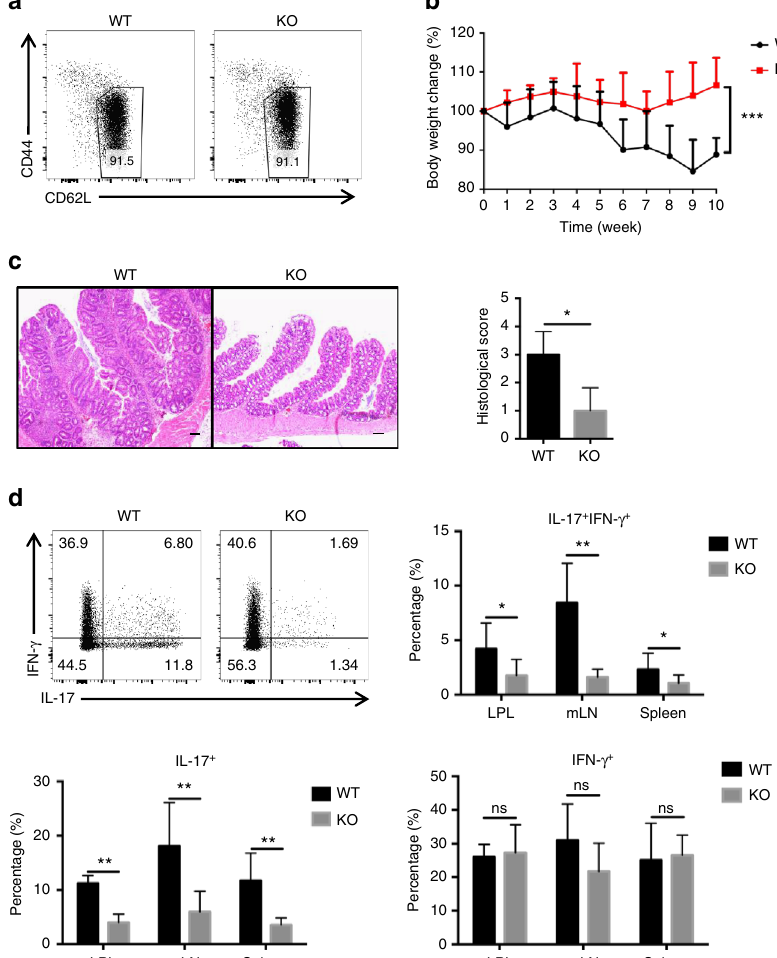
Fig. 1 TRIM28 regulated Th17 cell differentiation in vivo. a Naive T cells (CD4 + CD25 − CD62L hi CD44 lo ) isolated from the spleen and peripheral lymph nodes in wild type (WT) and Trim28 − / − mice at the age of 6 – 7 weeks. b Body weight changes in Rag1 − / − mice receiving WT or Trim28 − / − naive CD4 + CD25 − CD62L hi CD45RB hi T cells in the transfer colitis model (WT: n = 6, Trim28 − / − : n = 6, two mice in WT group died before sacri fi ced), and two- way ANOVA was used for the statistical test. c H&E staining of the large intestines of Rag1 − / − mice receiving WT or Trim28 − / − naive T cells (scale bars: 100 μ m). d Intracellular staining results and statistic data of the IL-17 and IFN- γ expression in the lamina propria (LPL) of large intestine, mesenteric lymph nodes (mLN), and spleen (WT: n = 4, Trim28 − / − : n = 6) and Student ’ s t test was used for the statistical test (ns = not signi fi cant; * p < 0.05, ** p < 0.01, *** p < 0.005). All error bars represent SDs. These experiments were repeated for three times with the consistent